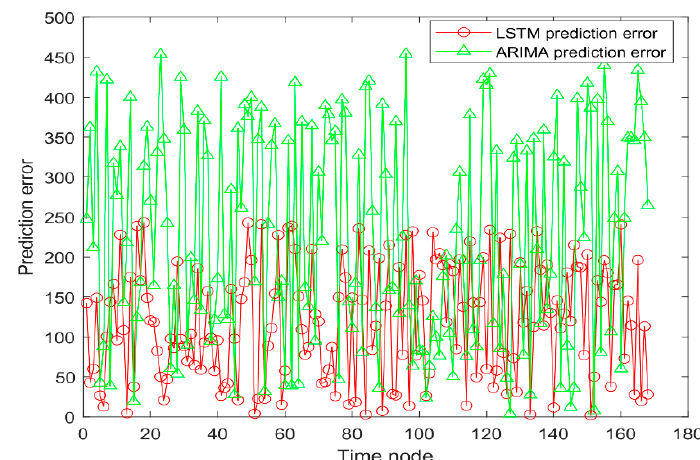
Figure 8. Traffic prediction error of base station Cell_000111.